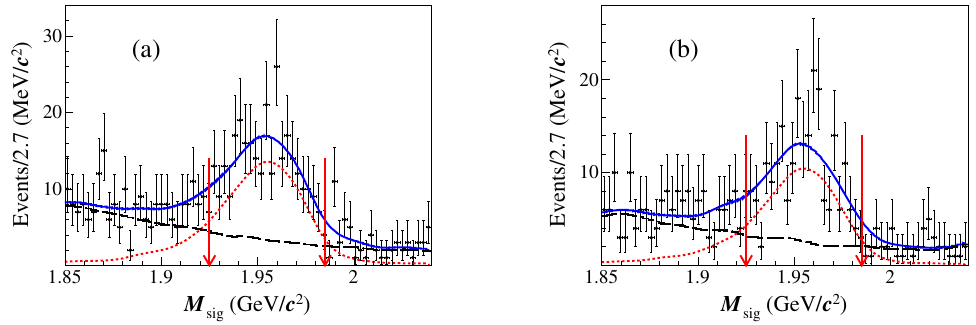
√ s = (a) 4.178 GeV and (b) 4.189-